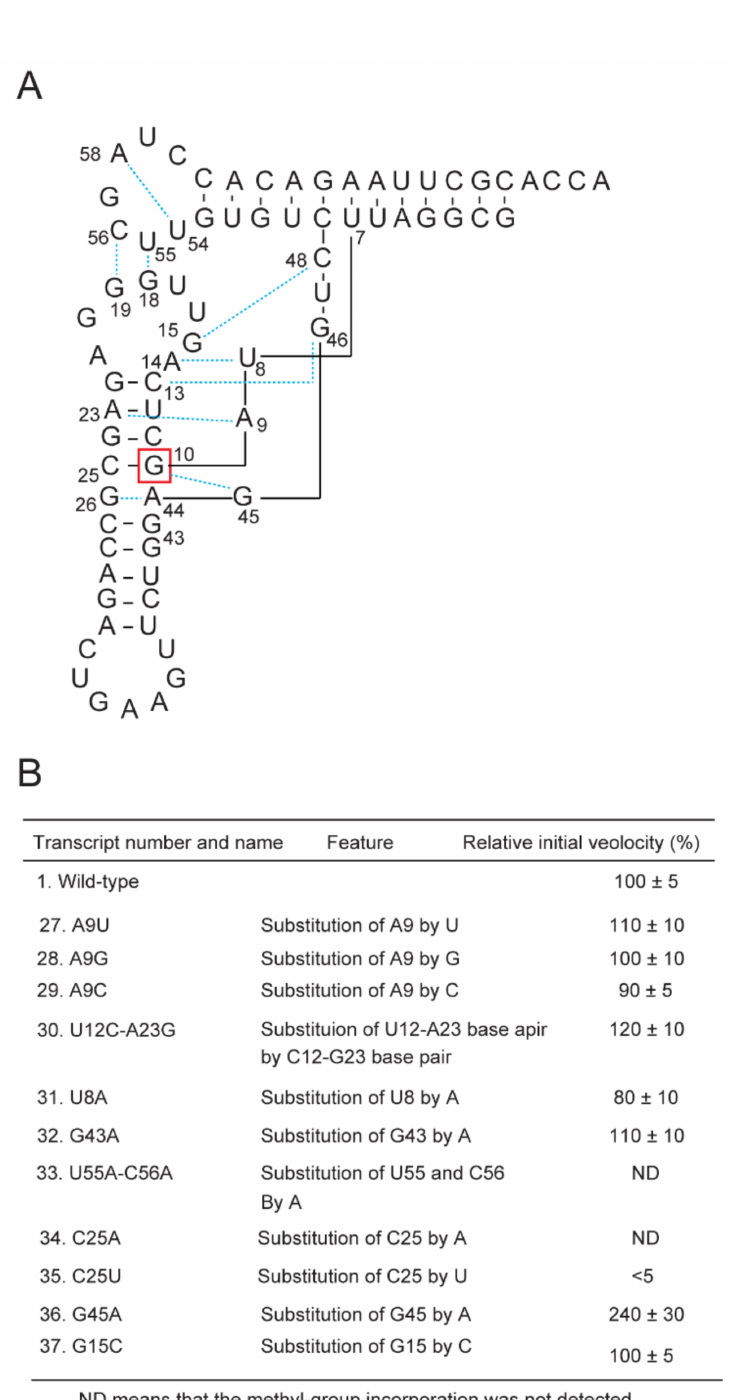
Figure 6. Effect of disruption of tertiary base pair or stem structure on methylation by Trm11-Trm112. ( A ) Tertiary base pairs (cyan dotted lines) are formed in tRNA Phe . The methylation site G10 is highlighted in a red square. The numbers show the positions in tRNA. ( B ) To disrupt tertiary base pairs, mutations were introduced into the tRNA Phe transcript. For example, in the case of transcript 27, A9 in the tRNA Phe transcript was substituted by U. As a result, the A9-A23 tertiary base pair was disrupted. The initial velocity of methyl-transfer to the wild-type tRNA Phe transcript is expressed as 100%. The data in this figure are averages of the results from four independent experiments. “ND” means that methyl-transfer was not